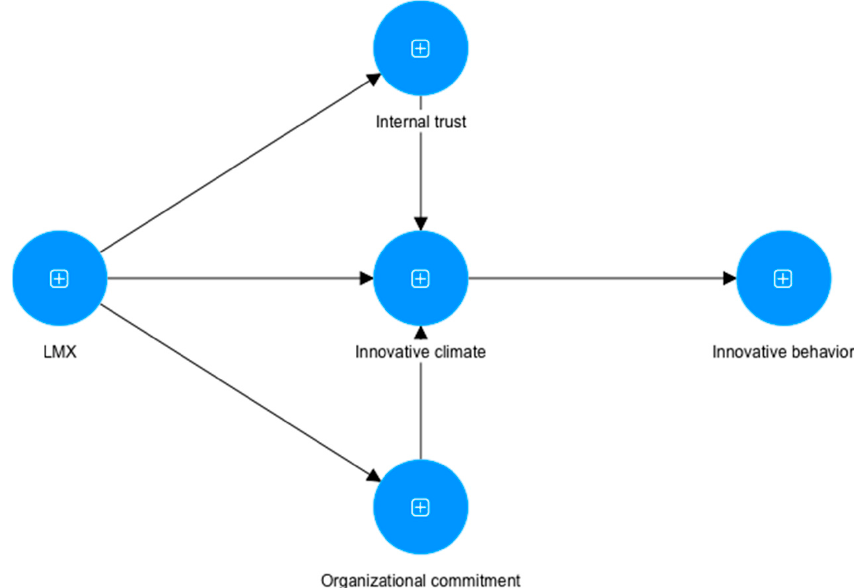
Figure 1. The conceptual model.